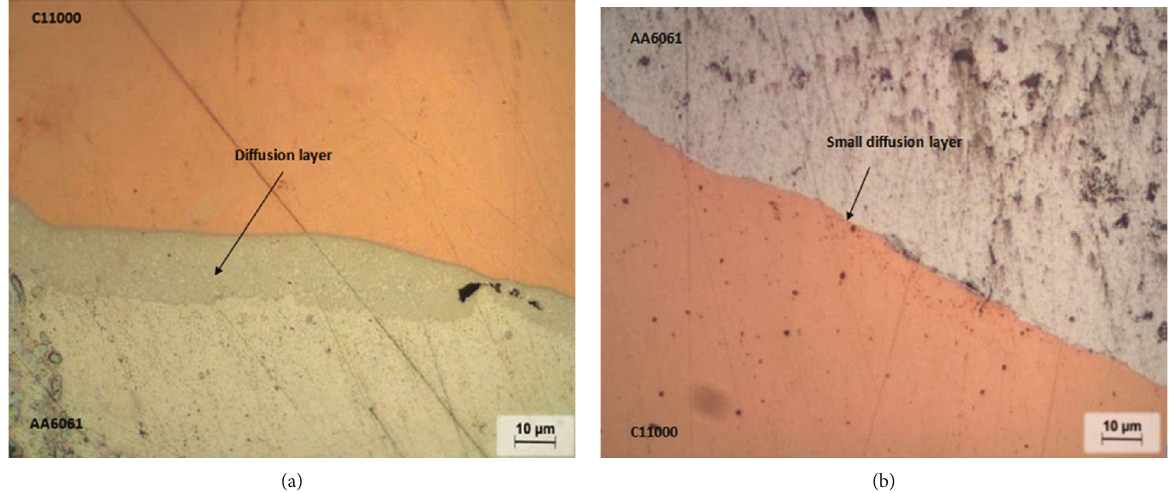
Figure 3: Microstructures of friction stir spot-welded Al-Cu wires (a) rotational speed: 1400rpm, dwell time, and 5s (b) rotational speed: 1400rpm, dwell time: 1s.